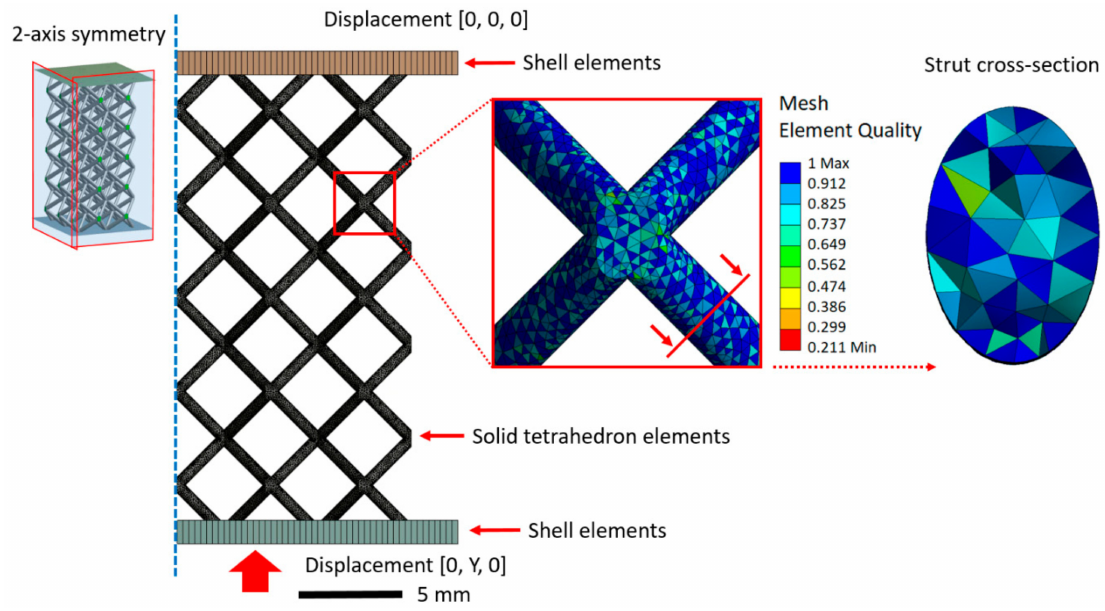
Figure 5. The meshed geometry of the lattice structure with boundary